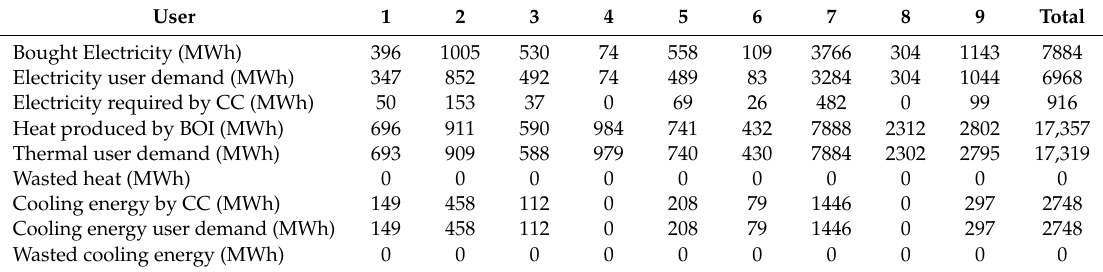
Table 5. Optimal annual energy magnitudes (MWh)—conventional